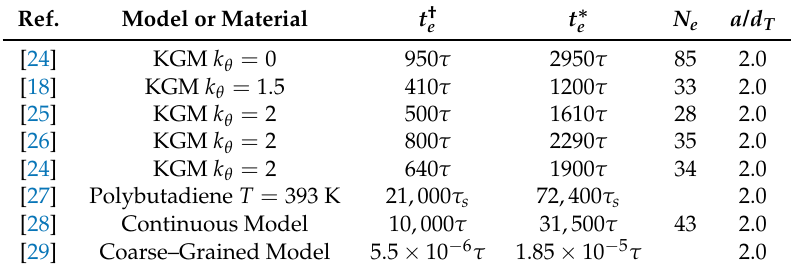
Table 1. Entanglement parameters for linear polymer melts measured via MSD. For time units, see the original